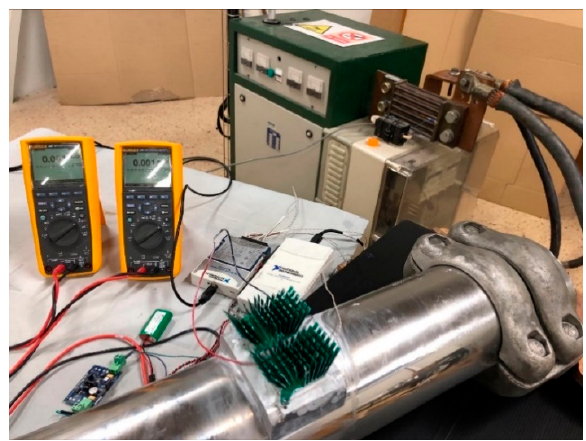
Figure 7. Experimental setup to characterize the performance of TEG #1 + DC/DC converter #1 mounted on a tubular conductor.